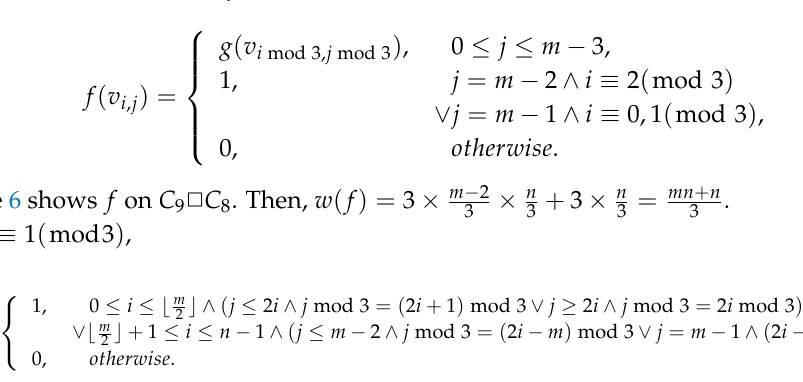
1 ( mod2 ) . Figure 5. f on C n (cid:50) C 22 for n 1 ( mod2 ) ≡ ≡